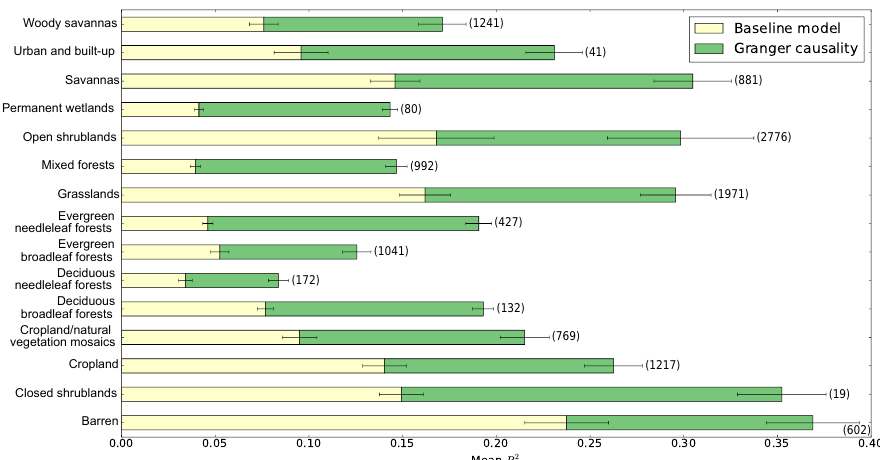
Figure 6. Mean R 2 and variance per IGBP land cover class for both the baseline and full random forest model. The green part indicates the improvement in performance of the full model with respect to the baseline, i.e. the quantification of Granger causality (as in Fig. 5b). The number of pixels per IGBP class is noted in the